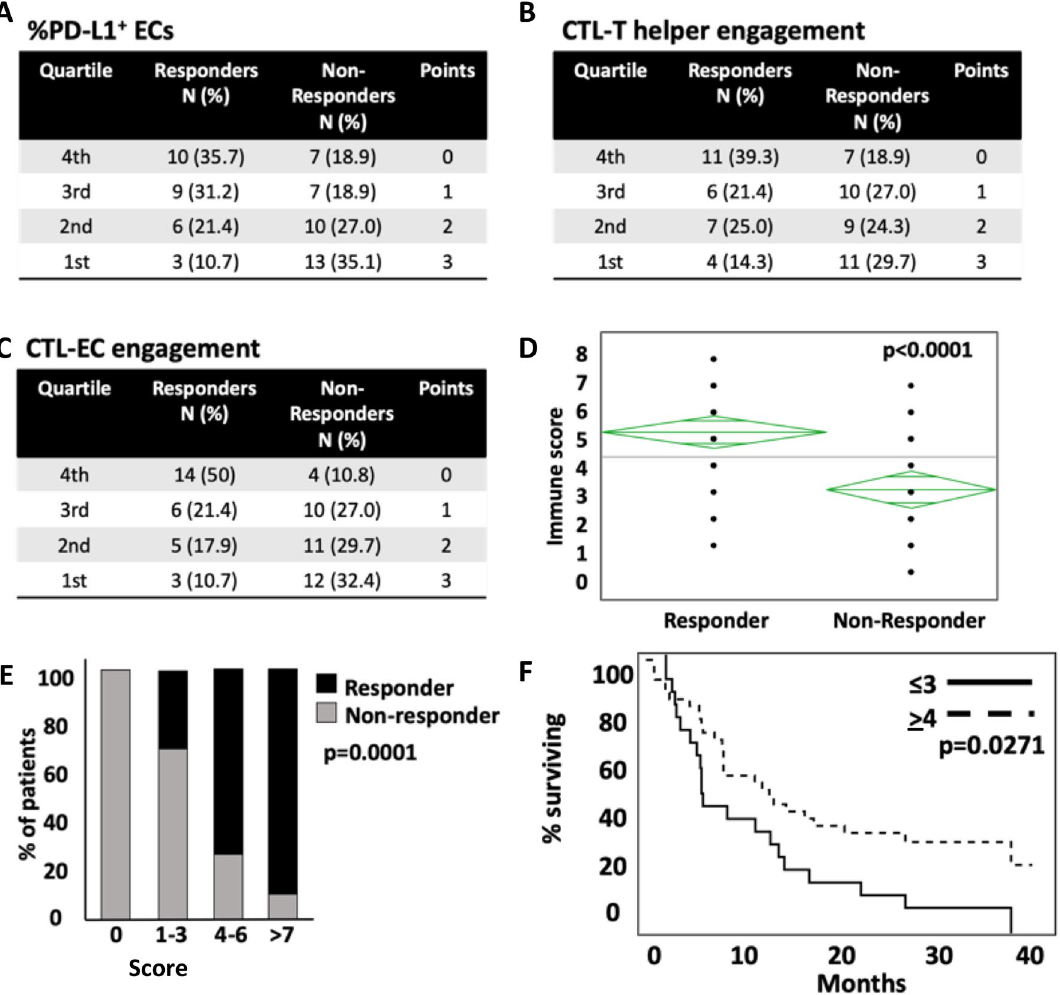
Figure 4. Combining spatial relationships with tumor PD-L1 to generate a spatial immune score to distinguish responders and non-responders to ICI. Each relationship, tumor PD-L1 ( A ), CTL-HTL engagement ( B ), and CTL-EC engagement ( C ) was divided into quartiles based on expression or degree of engagement. Each quartile was assigned a point, with 3 points assigned to the 1st quartile (representing greatest expression or engagement). The points were added up to generate the spatial immune score, with responders having a significantly higher score compared to non-responders ( D ). ( E ) Break down of spatial immune score between responders and non- responders. ( F ) All patients with zero points were